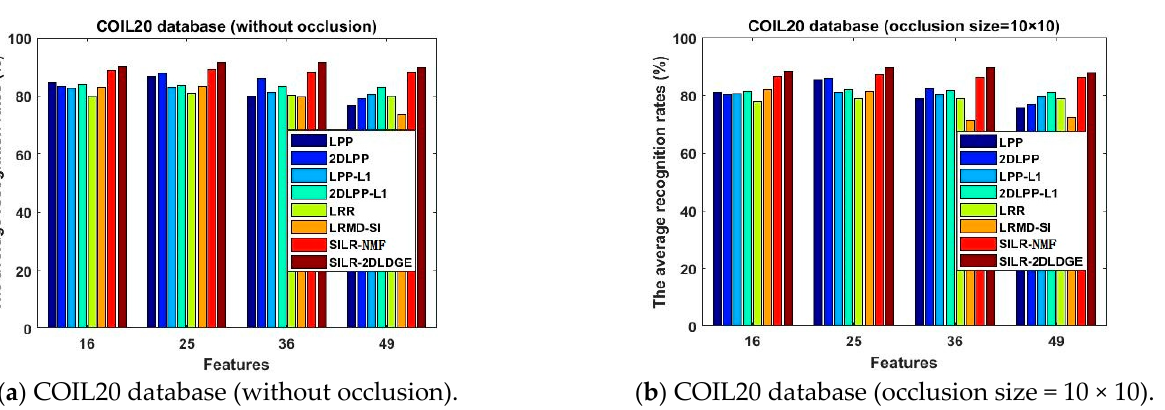
Figure 5. The average recognition rates (%) of the eight algorithms in COIL20 database vary with the dimension. Table 2. The best average recognition rates (%) of the eight algorithms in FERET, ORL, and COIL100 databases and the corresponding dimensions (D).